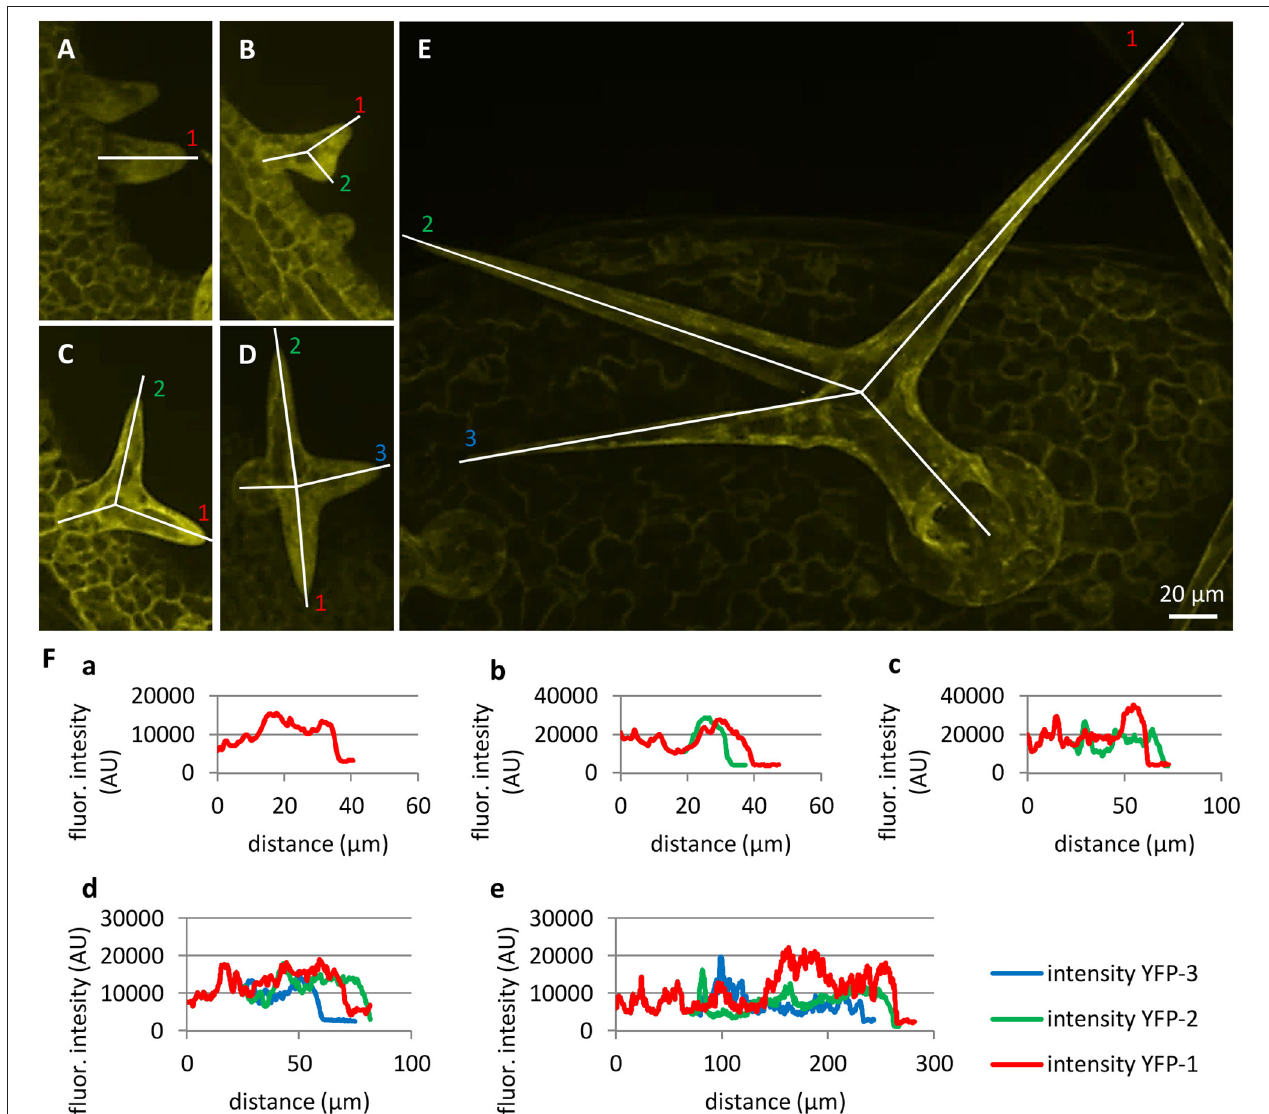
FIGURE 6 | Localization and accumulation of PLD α 1-YFP in developing leaf trichomes in pld α 1-2 mutant plants stably expressing PLD α 1-YFP driven by PLD α 1 own promoter. Images of maximum intensity projection were reconstructed from individual optical sections taken at the same live cell imaging condition from first (B,D,E) and second (A,C) true leaves of pld α 1-2 mutants stably expressing PLD α 1-YFP. Developing trichomes are displayed from early developing stages with no branches (A) , with progressing two branches (B, C) , growing three branches (D) to maturating three branches (E) . (F) Profiles of fluorescence intensity of YFP distribution in individual trichome branches indicated by lines in (A–E)